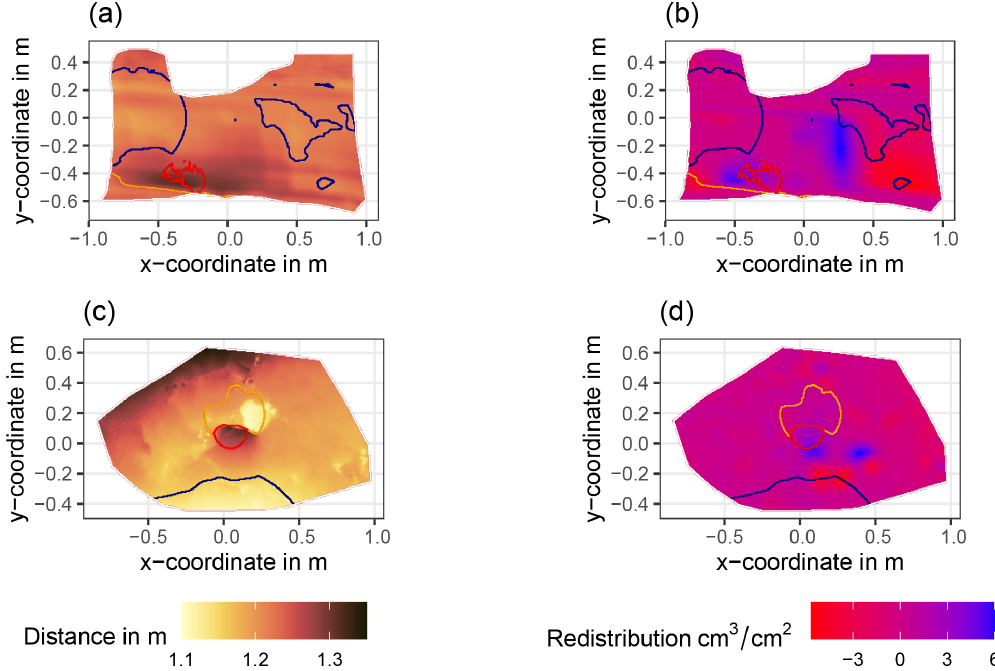
Figure A6. Examples of surface scans showing the digital surface model (DSM) before a rainfall event (a, c) at two camera locations at La Campana and the calculated volume of redistributed sediment (b, d) after the rainfall event: (a) DSM of a scan from the camera on the north-facing upper hillslope at La Campana, (b) detected sediment redistribution (cm 3 cm − 2 ) on the north-facing upper hillslope at La Campana after a rainfall event of 17.2mmd − 1 ;, (c) DSM of a scan from the camera on the south-facing upper hillslope at La Campana, and (d) detected sediment redistribution (cm 3 cm − 2 ) on the south-facing upper hillslope after a rainfall event of 17.2mmd − 1 . The red lines show the outline of the burrow entrance. The blue lines show the outline of mound. The orange line shows the outline of the burrow roof. The area that is not outlined is the burrow-embedded area. Redistribution is the volume of the redistributed sediment (per cm 3 cm − 2 ), either accumulated (positive value) or eroded (negative value). After the rainfall events, sediment mostly accumulated within the burrow entrance or near mounds and eroded from burrow roofs and